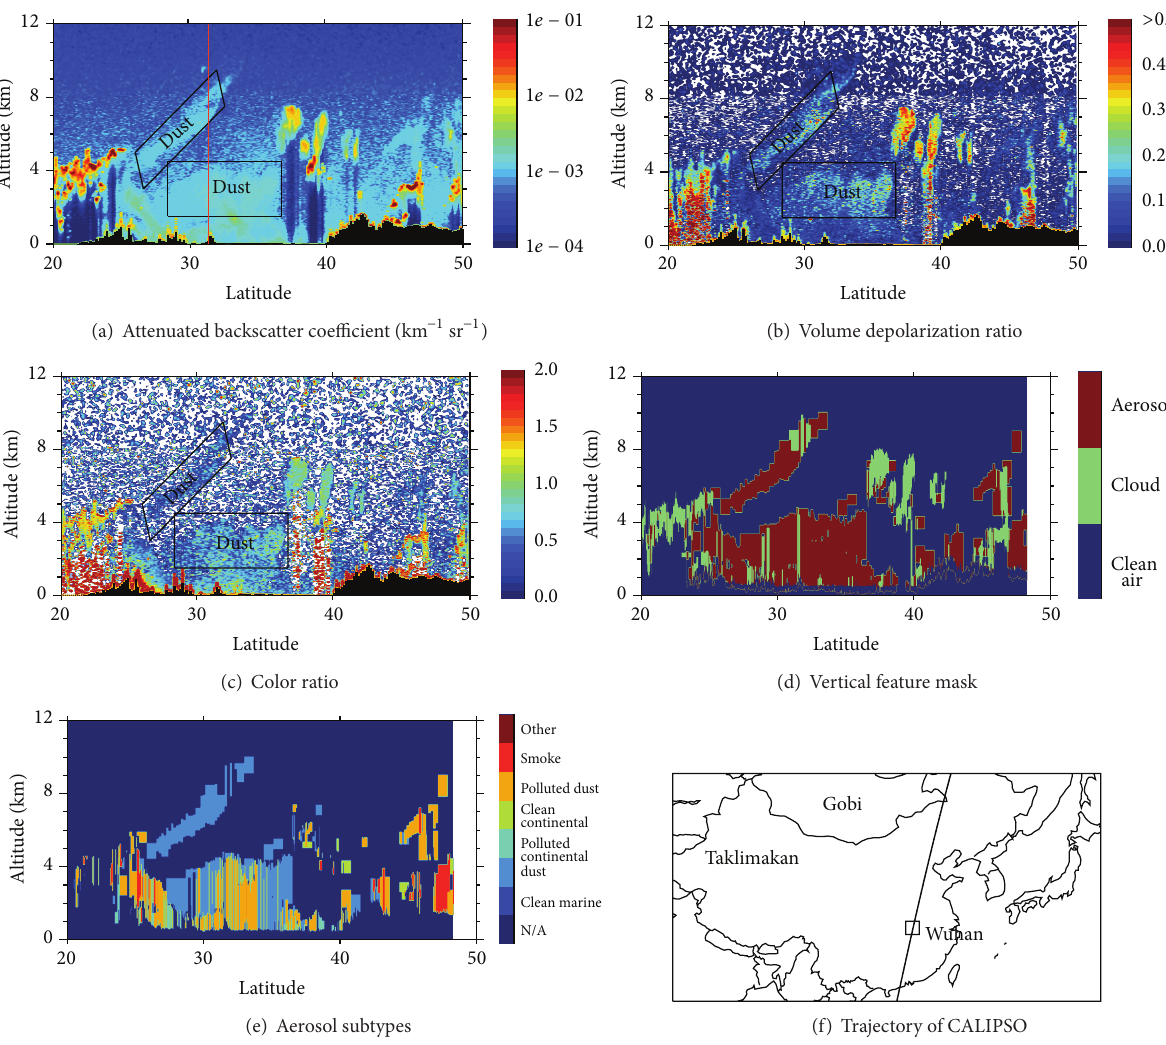
Figure 5: CALIPSO altitude-orbit cross-section measurements of (a) 532 nm total attenuated backscatter coefficient, (b) volume depolarization ratio, and (c) 1064 nm/532 nm backscatter color ratio; the figure shows the (d) vertical feature mask, (e) aerosol subtype mask, and (f) CALIPSO trajectory in the map (the corresponding orbit is 2011-04-22T18-16-45) over southeast China between 20 ∘ and 50 ∘ N on 22 April 2011. The red line (see (a)) marks the location of Wuhan. The locations of Taklimakan, Gobi, and Wuhan are marked in